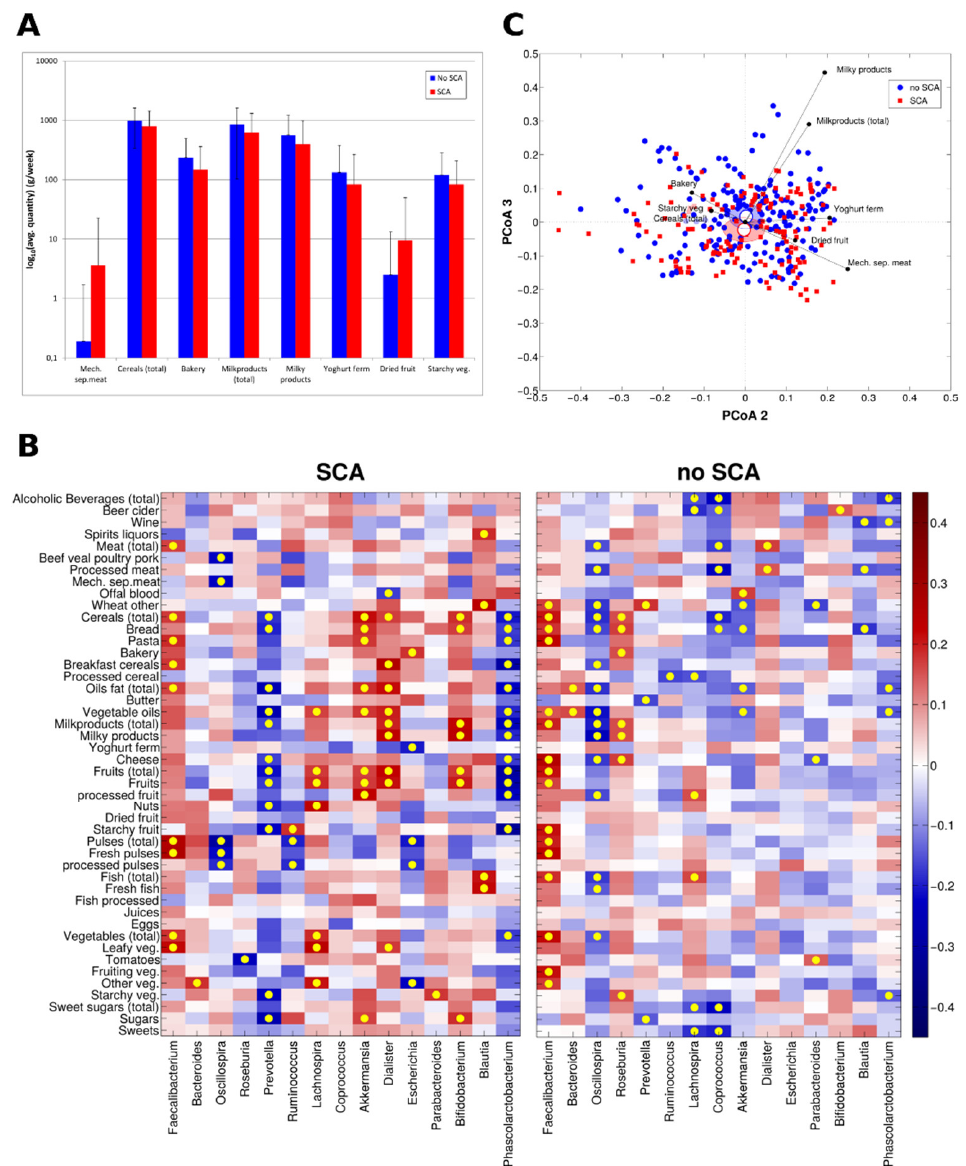
Figure 4. ( A ) Barplots of significantly different ( p < 0.05, Mann-Whitney U-test) nutrients based on the analysis of daily food diaries for individuals with ( n = 144) and without ( n = 201) SCA. Bars represent average intake and standard deviations are represented as error bars. Due to graphical reasons, intakes were represented as log 10 ( B ) Heatmap of the Spearman’s correlation coefficients between bacterial genera relative abundances and nutrients intake. Correlations were calculated for individuals belonging to “SCA” ( n = 144) and “no SCA” ( n = 201), respectively. Yellow dots correspond to significant correlation ( p -value of the linear model < 0.05) and bacteria with an average relative abundance ≥ 1% in either experimental group were represented. ( C ) Biplot representing samples according to dietary patterns for individuals with ( n = 144) and without ( n = 201) SCA. Principal Coordinate Analysis (PCoA) was based on Bray-Curtis distances. Each point represents a sample, centroids represent the average coordinate for the data points in each category and ellipses represent the 95% Standard error of the mean (SEM)-based confidence interval of the data points. The second and third principal coordinates are represented. The average coordinates of the statistically different dietary component ( p < 0.05) weighted by the corresponding abundance per sample was superimposed on the PCoA plot to identify those mainly contributing to the ordination space (black